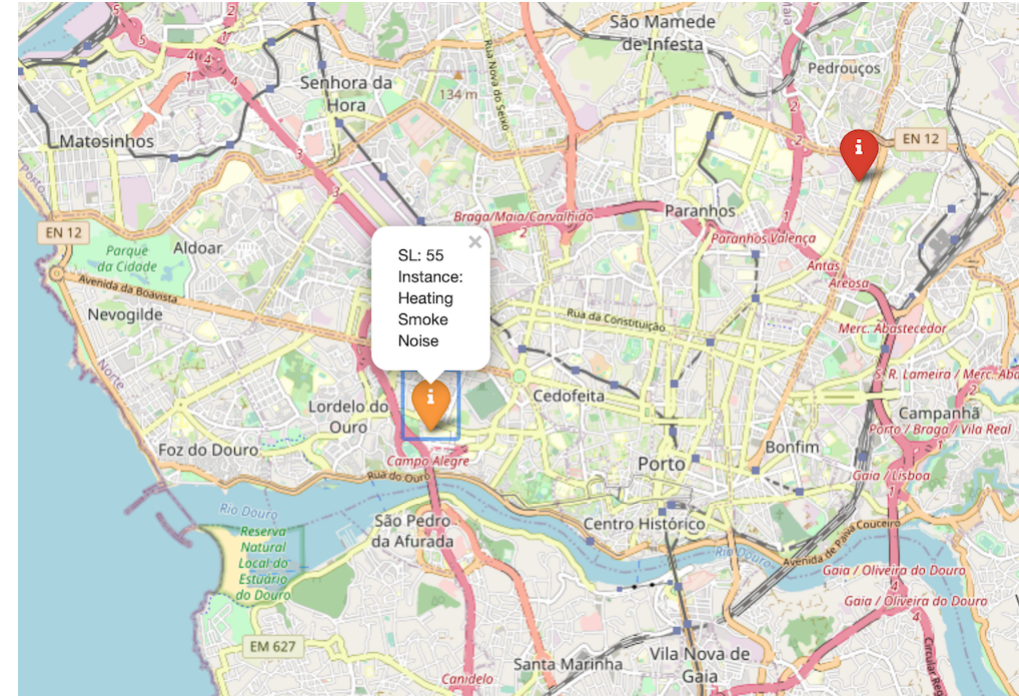
Figure 12. The events that comprise the alarm are displayed when we click on the